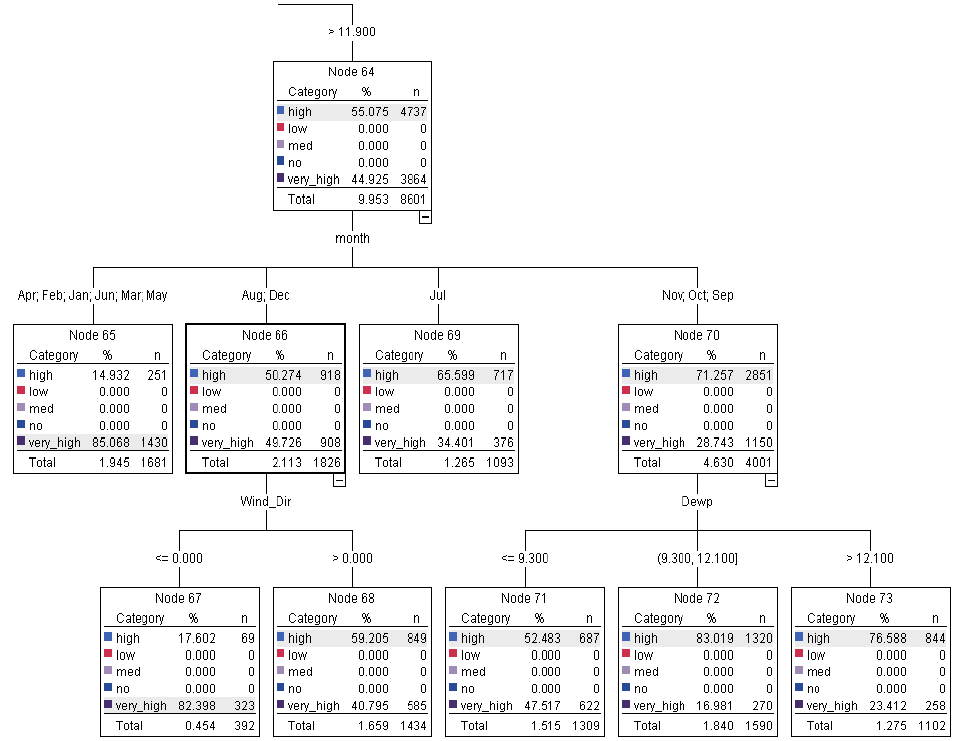
Figure 6. CHAID tree node (>11.9 wind speed nodes 64–73) and rules relating to gust classes (no, low, med, high and very